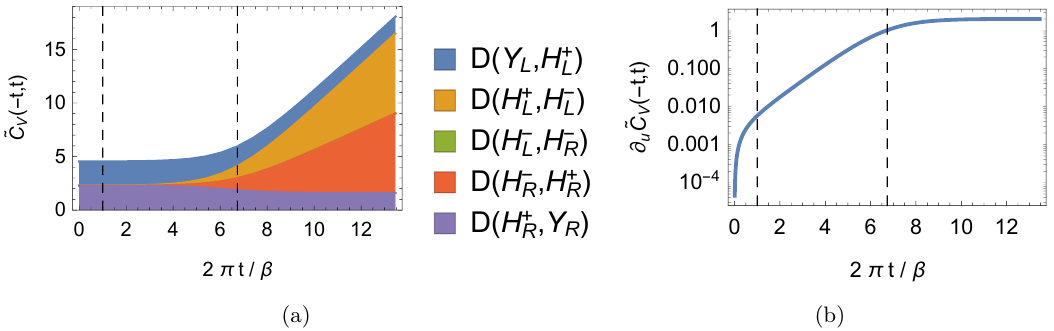
Figure 5 . (a) The complexity growth of a light Heisenberg operator, where the contributions from (cid:8) (cid:9) the intervals between points Y L , H + , H − , H − , H + , Y R are shown, where the contribution from L L R R D ( H − , H − ) is too small to be seen. (b) The time derivative of the complexity growth. The two L R dashed lines indicate the dissipation time t d and the scrambling time t ∗ in (3.25). The parameters are Q = 100 , L = 30 , θ = 0 , and µ = 0 . 1